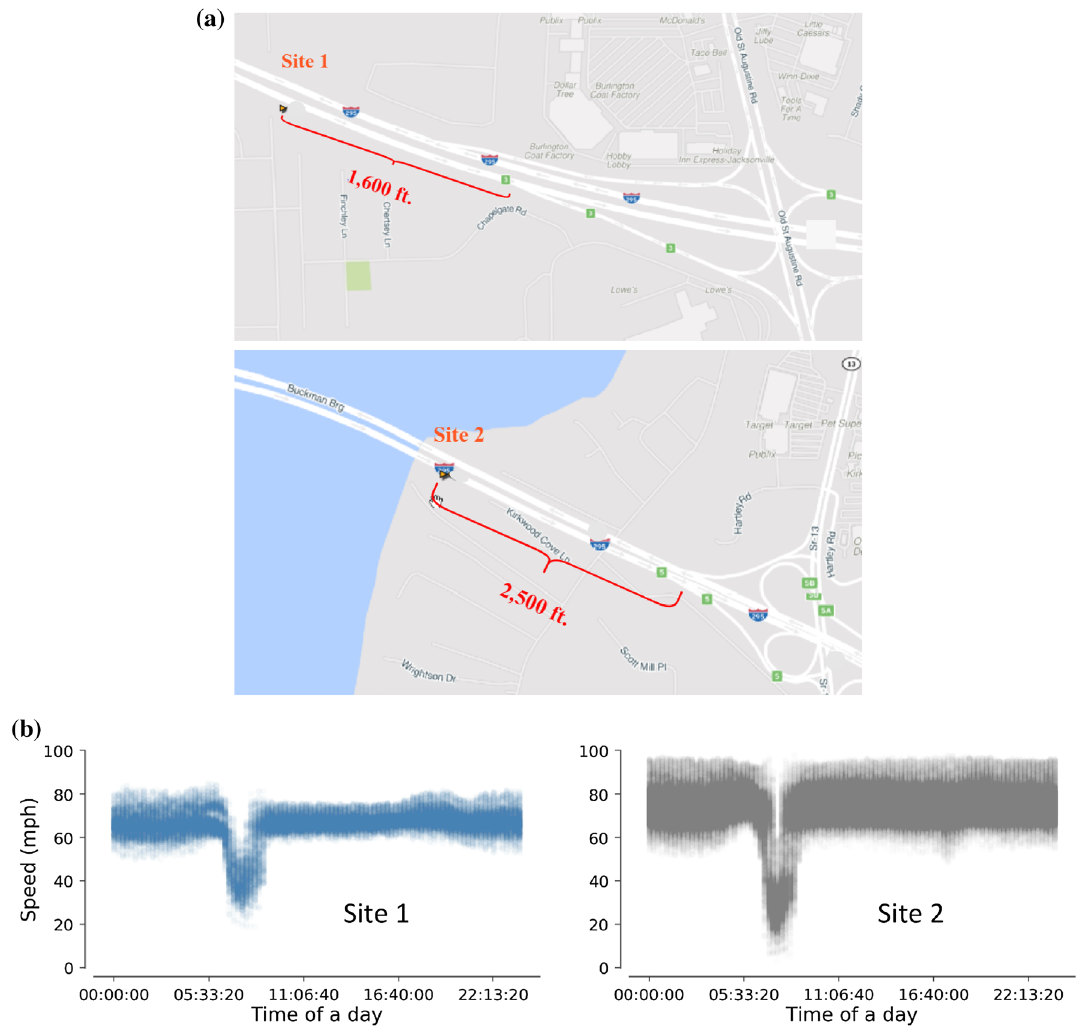
Fig. 1 Detector locations on Google map ( a ) and 24-h profiles of the traffic flow parameters at the two sites ( b